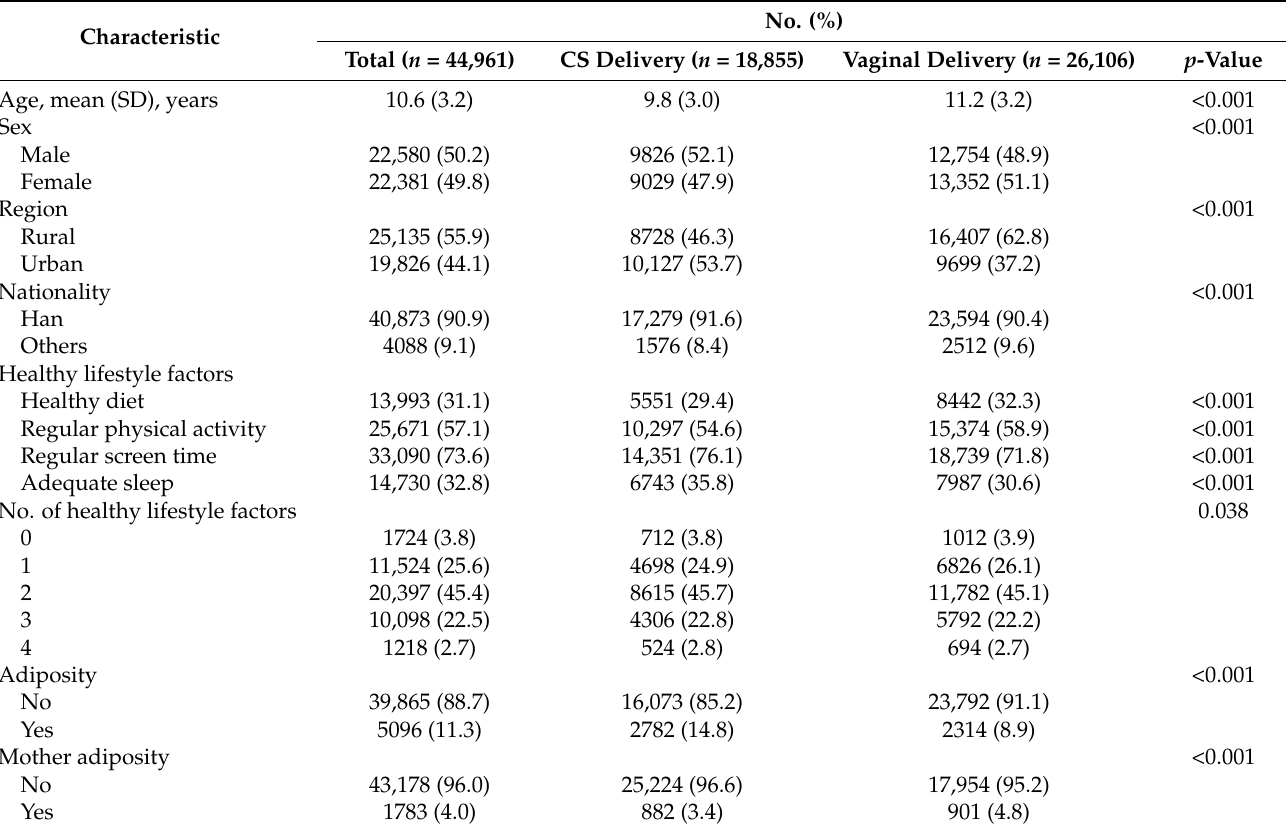
Table 1. Basic characteristics of study population in a study of the association between delivery and lifestyle with obesity in children and adolescents aged 6–18